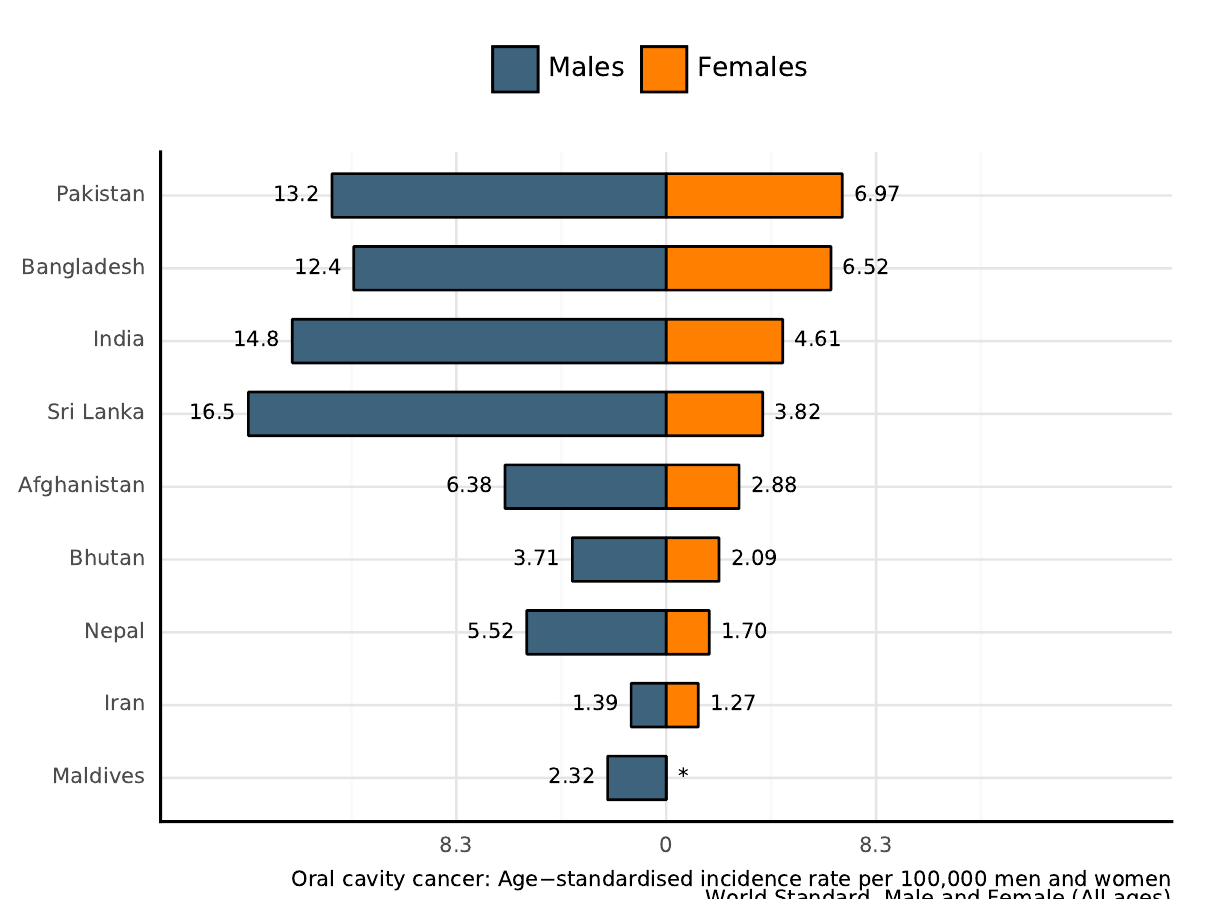
Oral cavity cancer: Age standardised incidence rate per 100,000 men and women World Standard. Male and Female